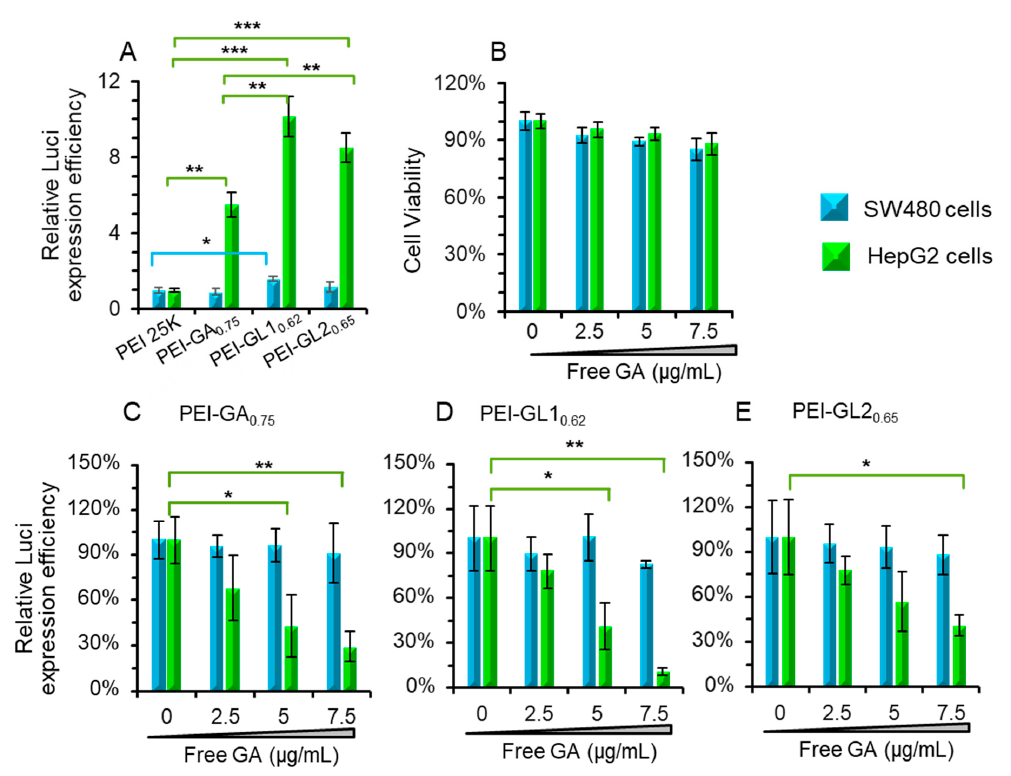
Figure 6. Free GA competition assay. ( A ) Relative transfection e ffi ciency of PEI25K, PEI-GA and PEI-GL conjugates at their optimum weight ratio in SW480 and HepG2 cells. Values are given as the mean ± SD of triplicates. Statistically significant di ff erences ( A ) are indicated by ** p < 0.01 and *** p < 0.001 using t-test (unpaired). ( B ) Cell viability of free GA in SW480 and HepG2 cells. E ff ect of free GA (0, 2.5, 5 and 7.5 µ g / mL) in relative Luci expression e ffi ciency of PEI-GA 0.75 / pLUCI ( C ), PEI-GL1 0.62 / pLUCI ( D ) and GL2 0.65 / pLUCI ( E ) on HepG2 and SW480 cells. The results are shown as mean ± SD ( n = 3). Statistically significant differences ( C–E ) are indicated by * p < 0.05 and ** p < 0.01 using t -test (unpaired).